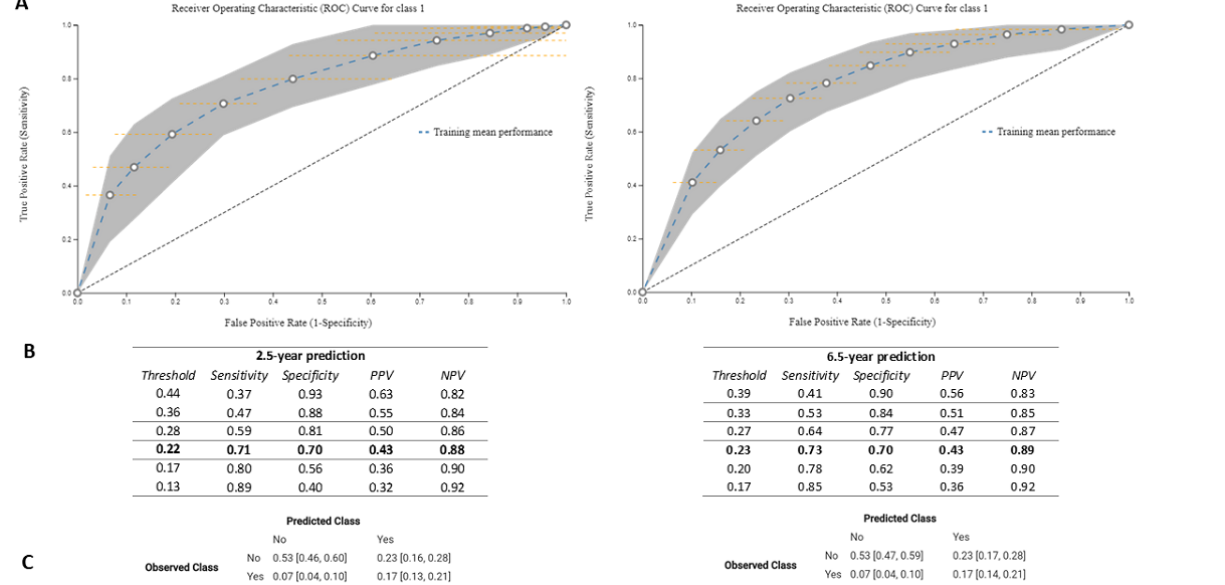
Figure 1. Results from the final prediction models (experiment 3): (A) receiver operating characteristic (ROC) curves for 2.5-year and 6.5-year predictions; (B) sensitivity, specificity, positive predictive value (PPV), and negative predictive value (NPV) for selected cutoffs on the ROC curve; (C) confusion matrices for selected cutoffs on the ROC curve (marked in bold in Panel